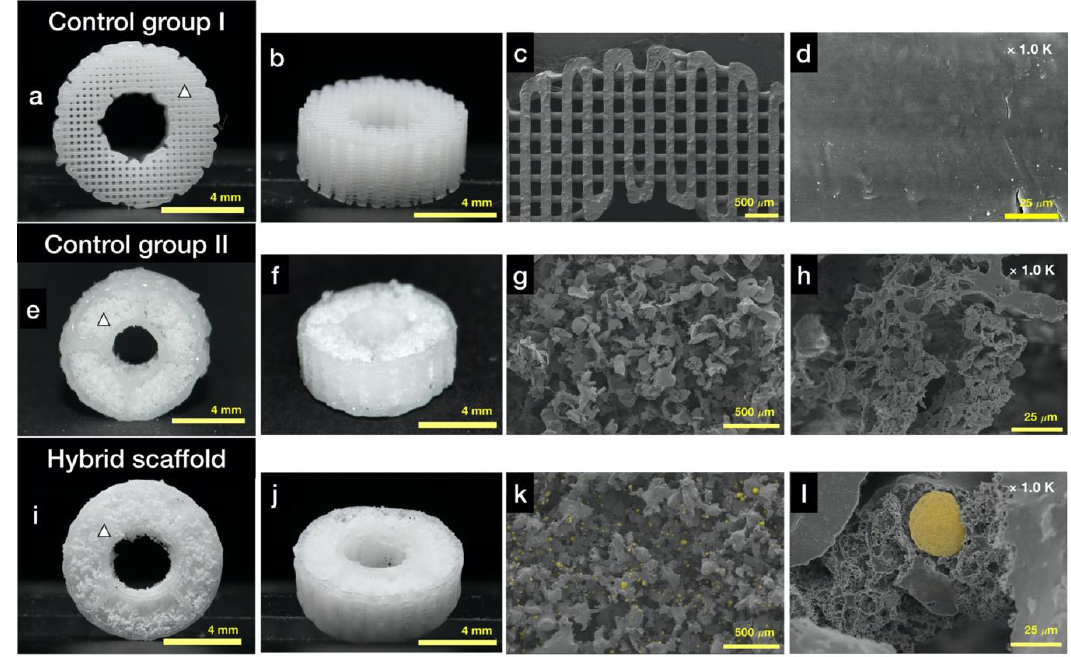
Figure 3. Morphological analysis using optical camera and FE-SEM: ( a ) photograph of the top view of control group I (white triangle: position of the Figure 3d); ( b ) photograph of the isometric view of control group I; ( c ) FE-SEM image of the top view of control group I; ( d ) FE-SEM image of the surface of control group I; ( e ) photograph of the top view of control group II (hybrid sca ff old without HA / β -TCP, white triangle: position of the Figure 3h); ( f ) photograph of the isometric view of control group II; ( g ) FE-SEM image of the top view of control group II; ( h ) FE-SEM image of the surface of pores in control group II; ( i ) photograph of the top view of the hybrid sca ff old (white triangle: position of the Figure 3l); ( j ) photograph of the isometric view of the hybrid sca ff old; ( k ) FE-SEM image of the top view of the hybrid sca ff old (yellow dots: osteoconductive ceramic particles); and ( l ) FE-SEM image of the surface of pores in the hybrid sca ff old (yellow dot: osteoconductive ceramic particle). The energy-dispersive spectroscopy (EDS) analysis confirmed the exposure of HA and β -TCP particles in the hybrid sca ff old, as depicted in Figure 4. The P and Ca components were not detected in the PCL frame; on the contrary, the P and Ca components were detected in particles assumed to be HA and β -TCP (Figure